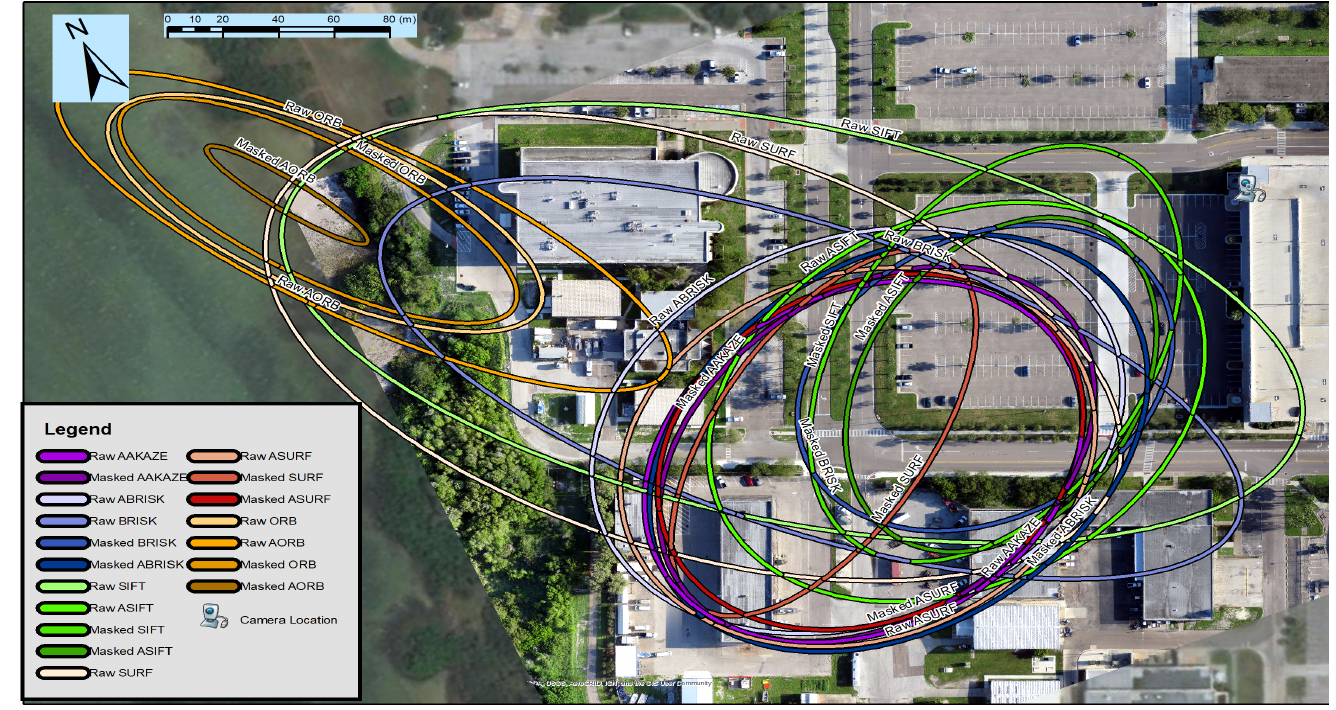
Figure 14. The standard deviations of position estimations in 2D, categorized by dataset and key- point